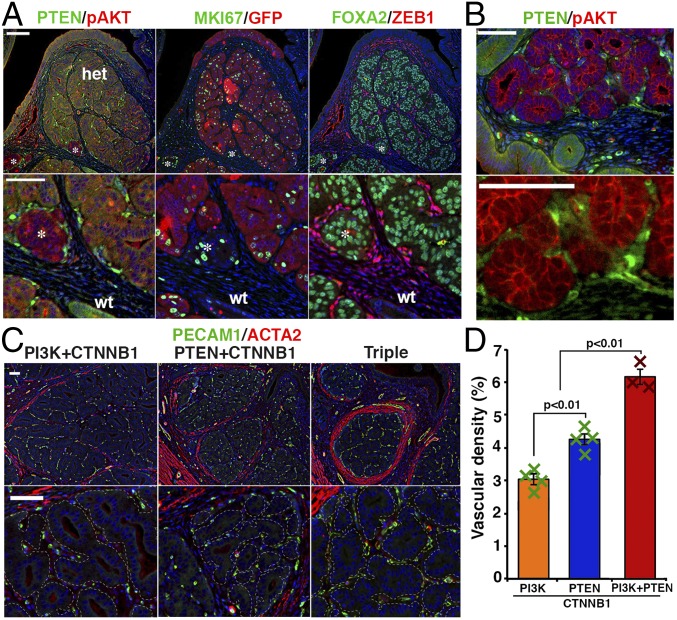
Gene-dose effect of PTEN, PI3K, and CTNNB1 mutations in uterine epithelial lesions. (A) In triple-gene mutant mice, dominant epithelial lesions expressed a low level of PTEN indicating monoallelic loss, EGFP (marker for PIK3CA* expression), and FOXA2 (markers for CTNNB1 mutation). Small clusters of PTEN-null, FOXA2-positive glands (PIK3CA* negative) were also detected (*). (B) Hyperplastic glands with PTEN mutation were closely associated with cells having intense PTEN immunostaining signals. Cellular morphology indicated they were endothelial cells. (C) Density and size of microvasculatures within hyperplastic lesions increased in triple-gene mutant mice compared with double-gene (PI3K+CTNNB1 and PTEN+CTNNB1) mutant mice. Microvasculatures are PECAM1-positive (green) and ACTA2-negative (red). Epithelial lesions were outlined with dotted lines. (Scale bars: 50 μm.) (D) Vascular density in the lobules of glandular hyperplasia in double-gene and tripe-gene mutant mice carrying the CTNNB1 mutant allele (2 mo). Result is presented by average ± SE.